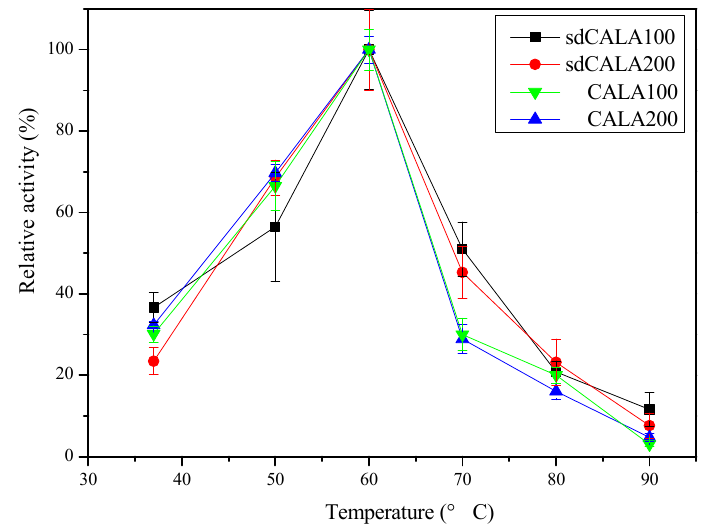
Figure 4. Effect of temperature on the relative activities of samples of CALA and sdCALA prepared at different shaking rates.